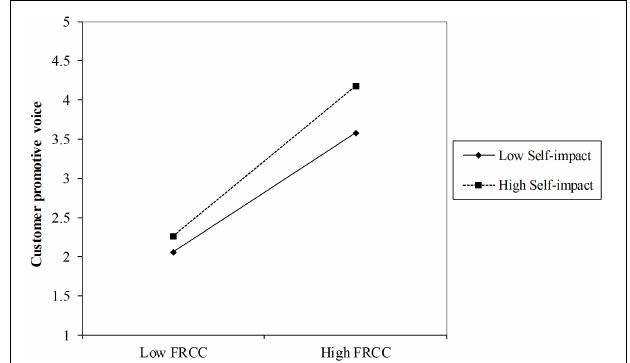
FIGURE 2 | Moderating effect of self-impact on the relationship between FRCC and customer promotive voice.